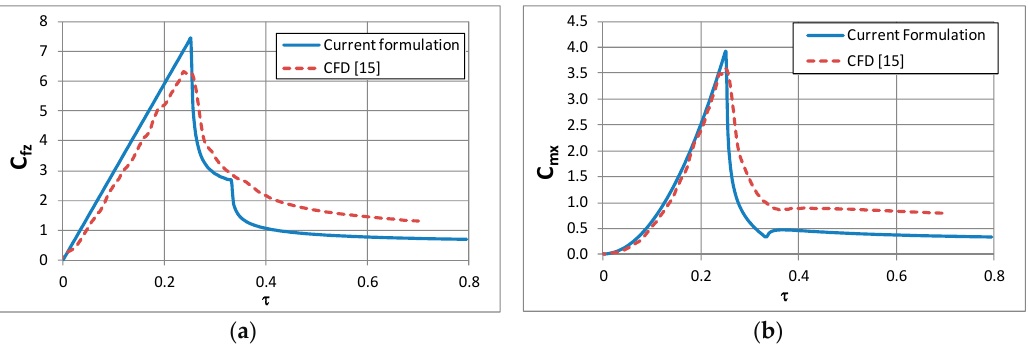
Figure 12. Forces variation during impact with horizontal velocity, β 1 = 20°, β 2 = 30°, and v / w = − 1.0. ( a ) Vertical force during the impact. ( b ) Roll moment during the impact.